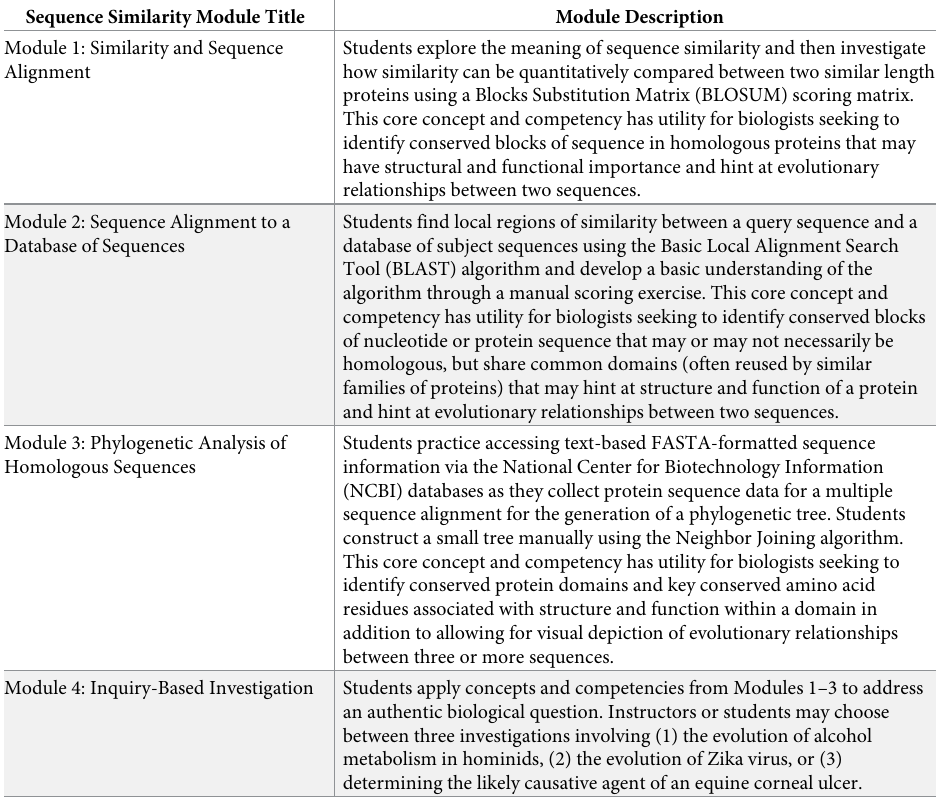
Table 1. Sequence similarity learning resource module